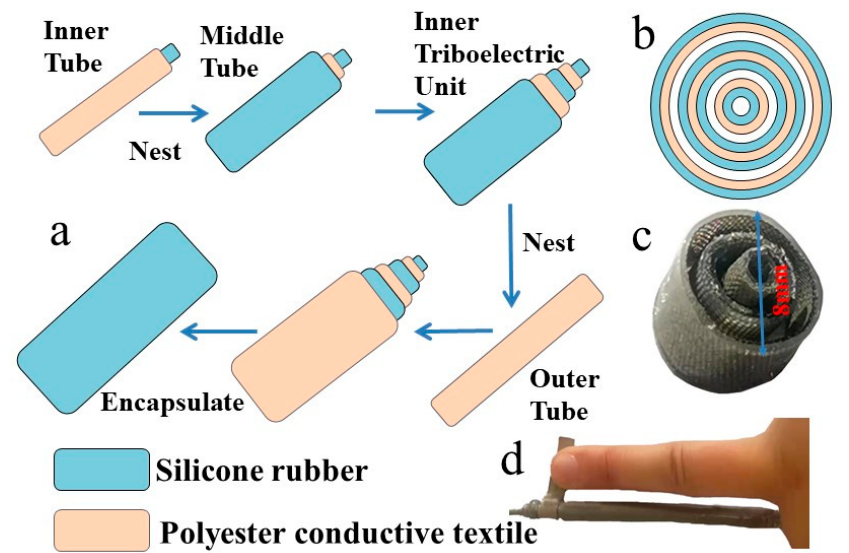
Figure 1. A structural schematic of the shared-electrode and nested-tube structure triboelectric nanogenerator (SNTN): ( a ) The fabrication processes of the SNTN; ( b ) A cross-sectional schematic diagram of the SNTN; ( c ) A cross-sectional image of the fabricated SNTN. ( d ) A comparison photo between the fabricated SNTN and the middle finger.